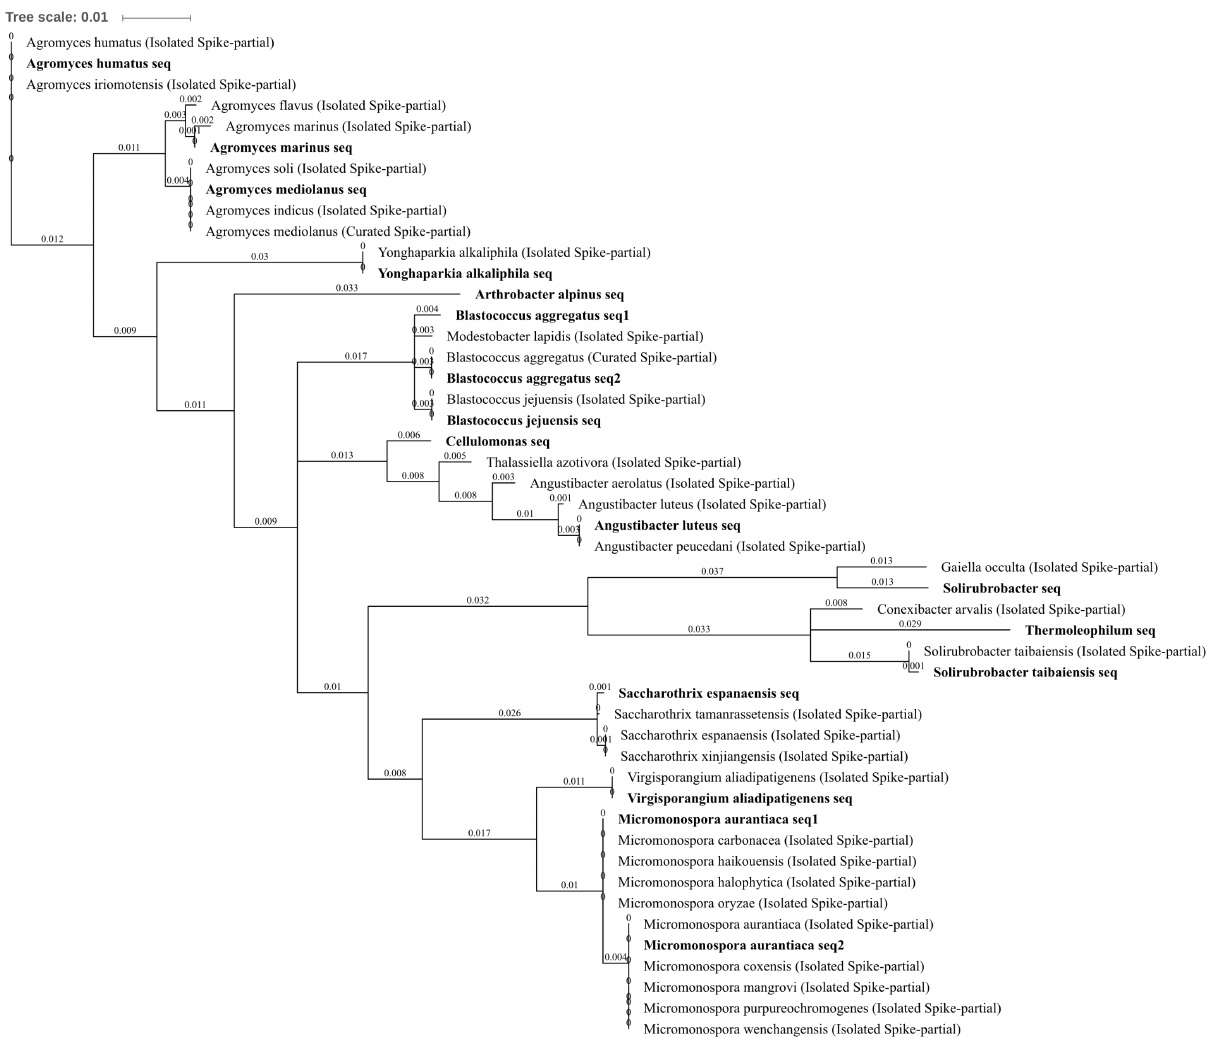
FIGURE 6 | Actinobacteria phylogenetic tree. Jukes–Cantor model with neighbor-joining and > 50% support threshold (1,000 replications). Sub-OTUs (distinct amplicons) are highlighted in bold with spike (into the tree) sequences included as the most similar hits from the NCBI bacteria and archaea 16S rRNA gene database. All accession numbers and sequences (sub-OTUs and tree spikes) are provided in Supplementary File 2 . The value “0.01” on the scale bar represents 1 substitution in 100